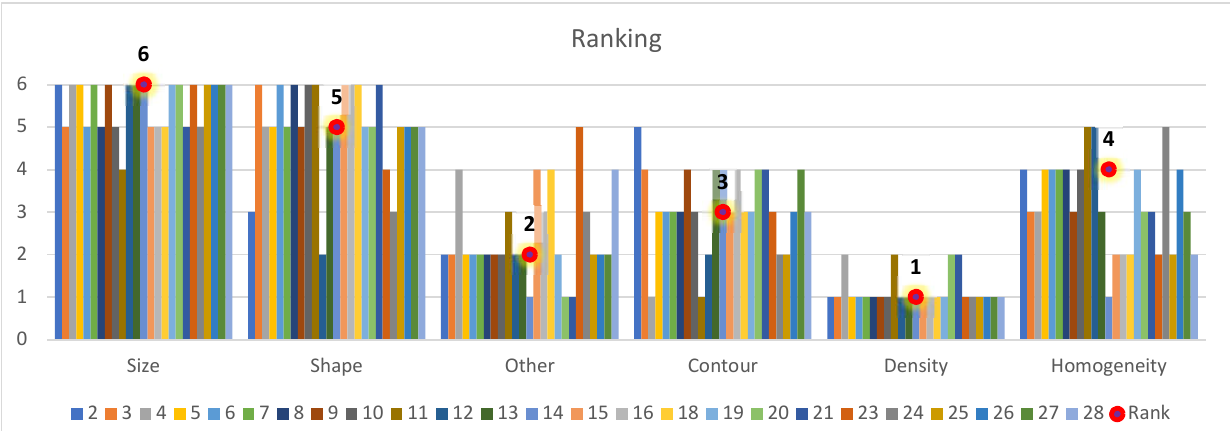
Figure 5. Ranking of the 6 attributes: size, shape, other features, contour, density, and homogeneity for the 25 consistently answering experts. The different attributes are denoted on the horizontal axis, the experts are shown by the color of the columns, according to the legend at the bottom of the plot. The aggregated rank is given by the red dots and the numbers above the attributes.